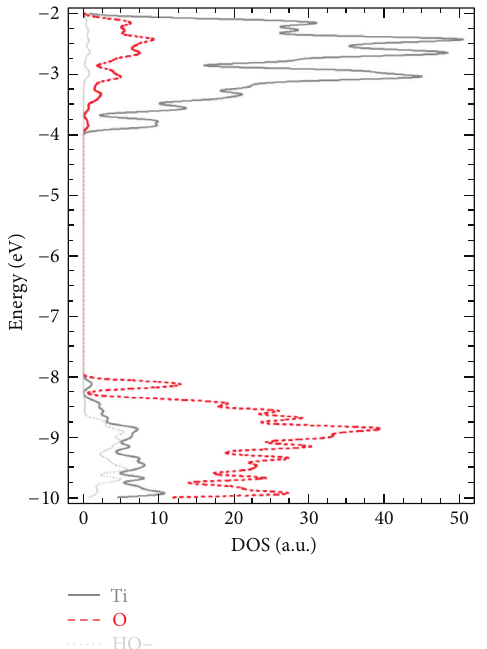
Figure 5: Density of states of the Ti 24 O 50 H 4 cluster calculated at DFT/B3LYP/DZVP level in water. The contributions of the orbitals to Ti and O atoms as well as to the –OH groups are shown separately.